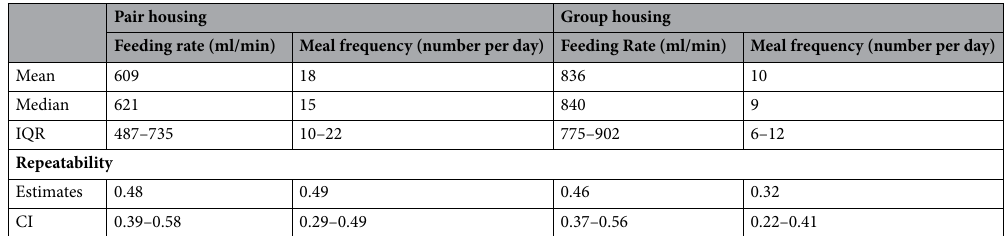
Table 3. Mean, median, inter-quartile range, repeatability, and coefficient of variation in predictability for meal frequency and feeding rate for the same calves by context (pair housing and group housing). IQR and CI correspond to interquartile range and credibility interval respectively.